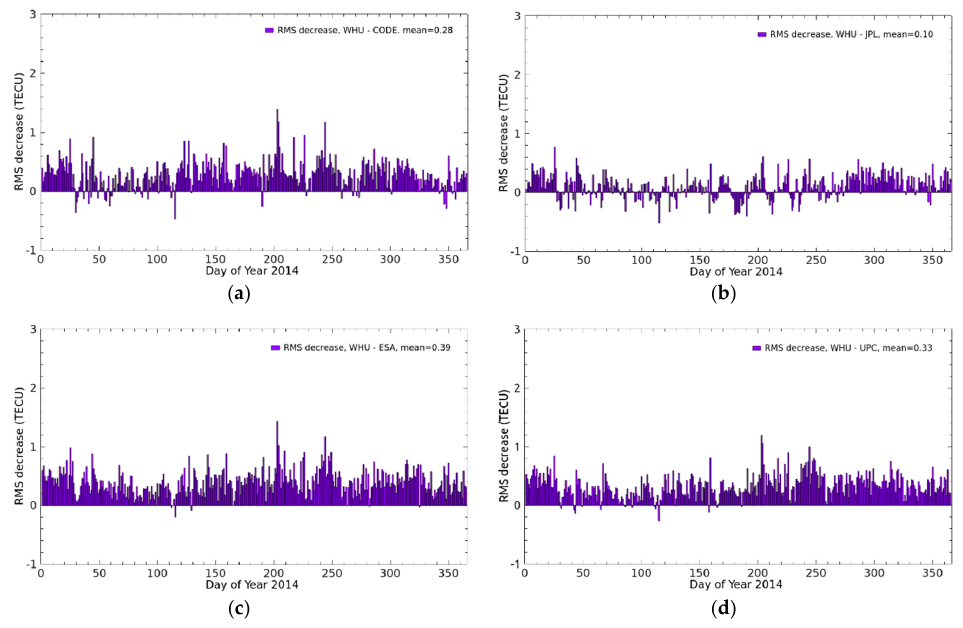
Figure 8. RMS decrease of differences in VTEC maps between WHU GIMs based on Bayesian estimation and IAAC GIMs compared to those between GIMs based on original LSE and the IGS final GIMs. ( a ) Compared with CODE. ( b ) Compared with JPL. ( c ) Compared with ESA. ( d ) Compared with UPC. Table 2. RMS decrease information for 2014 (unit: TECU).